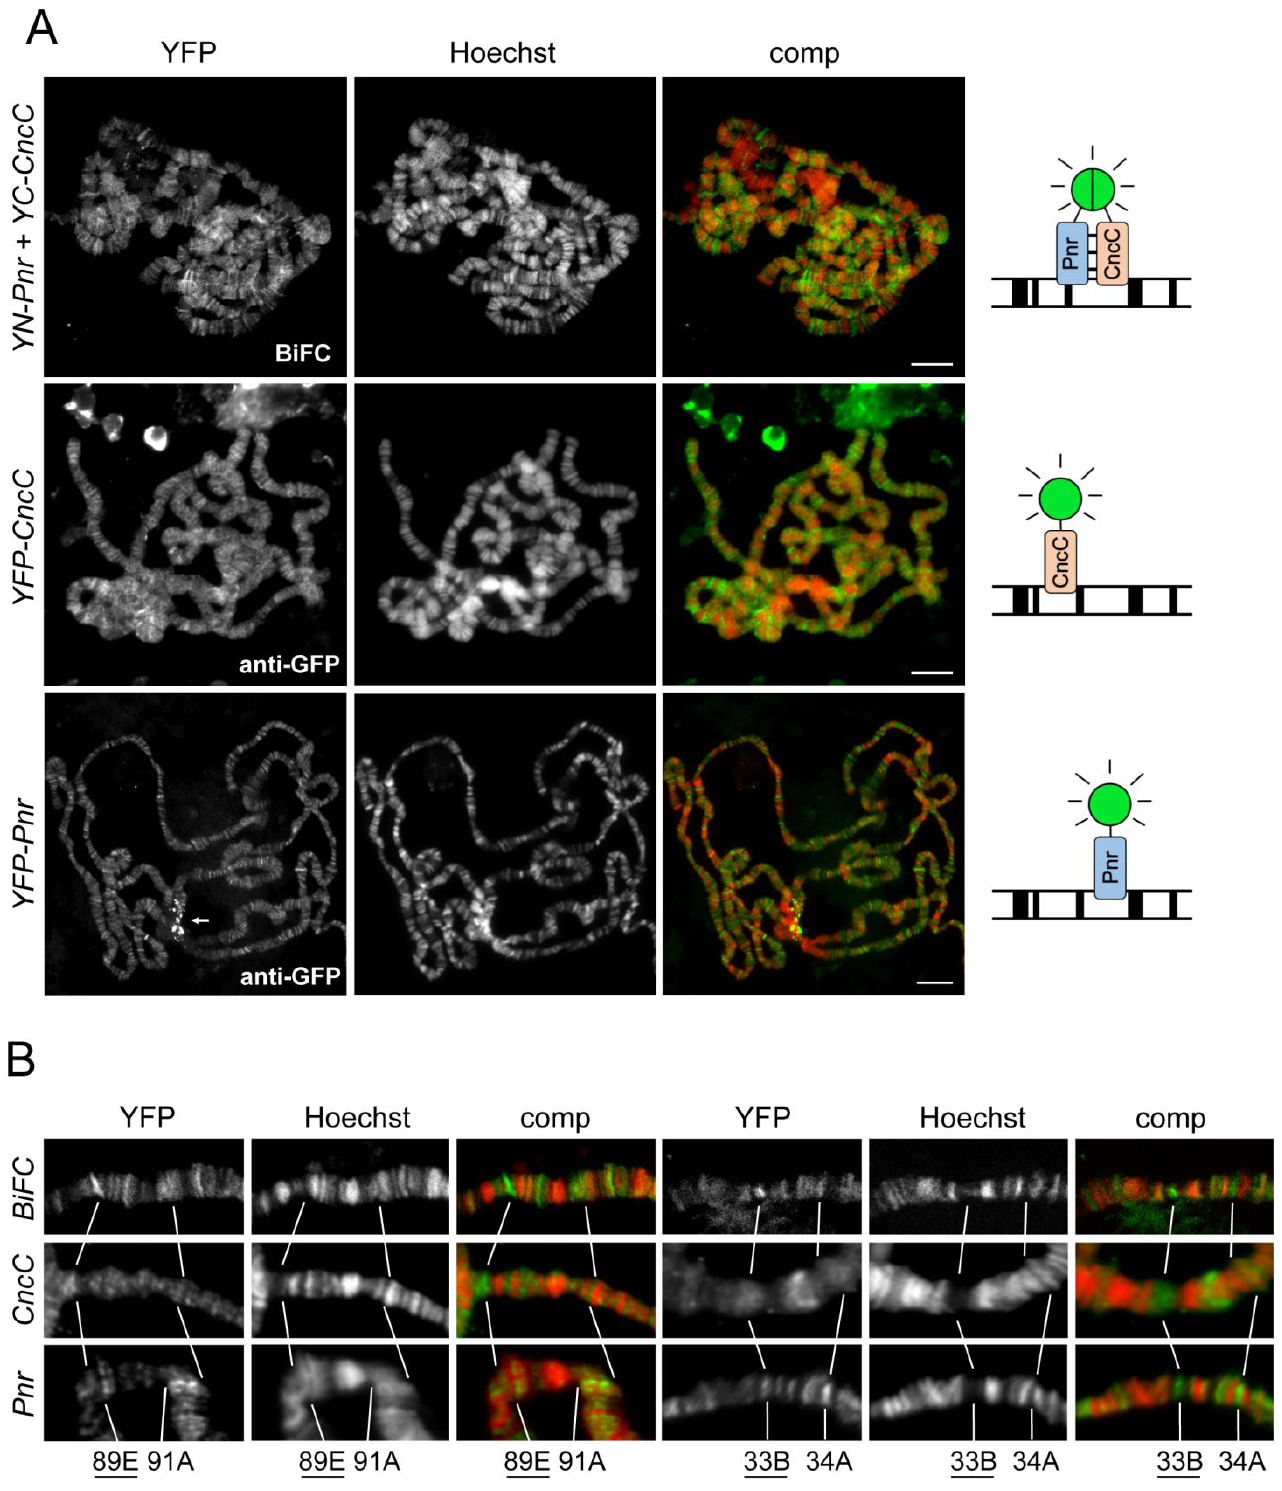
Figure 2. Visualization of CncC–Pnr BiFC complexes at chromatin loci: ( A ) Visualization of CncC–Pnr BiFC, YFP–CncC, and YFP–Pnr binding on polytene chromosomes. The fusion proteins indicated on the left were expressed in salivary glands using the Sgs3-GAL4 driver. CncC–Pnr BiFC fluorescence (green) was visualized intrinsically, while YFP–CncC and YFP–Pnr bindings were visualized by anti-GFP immunostaining (green). Polytene chromosome spreads were counterstained with Hoechst (red). The diagrams on the right depict the polytene chromosome BiFC assay of the